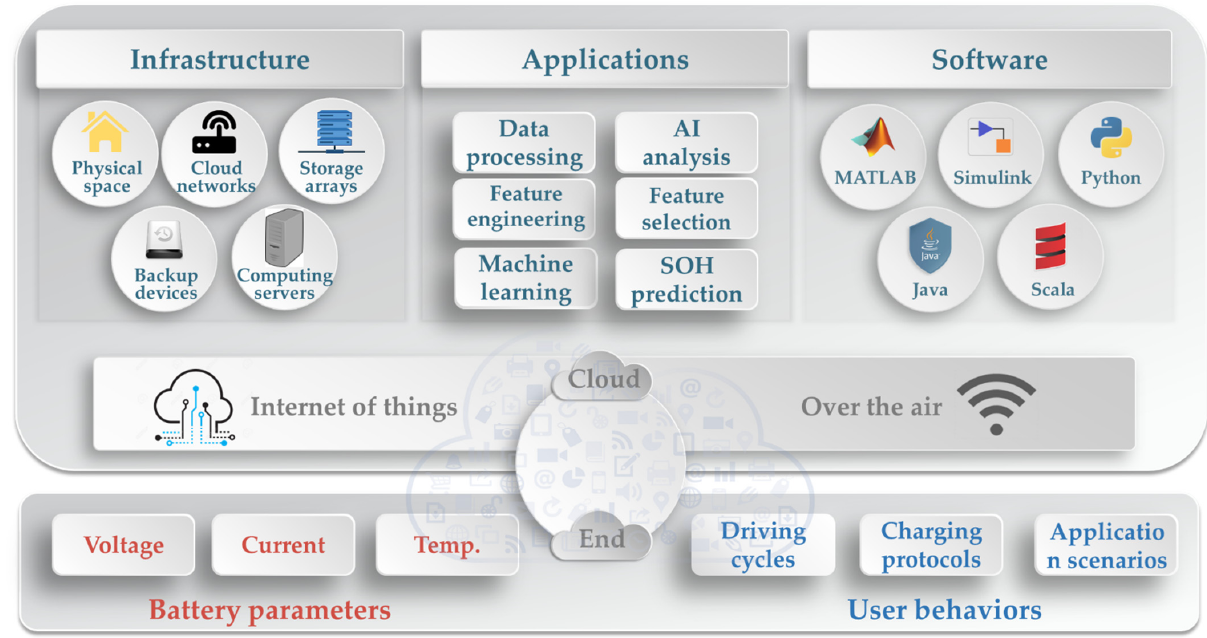
Figure 5. Cloud-based battery SOH estimation and prediction for real-world EV applications. Infra- structure and software constitute essential elements to a cloud platform. The sensor data generated from the Internet of things (IoT)-enabled vehicles can be seamlessly delivered to a cloud. Learning algorithm and physics-based modelling can be conducted on a cloud using both the battery param- eters generated during the daily operation of the battery system and the end-use behaviors during the daily operation of the vehicle. Over the air (OTA) technology provides tools for distributing new software that developed in an offline environment to the onboard actuators. Machine learning pipe- line approach, composed of data processing, feature engineering, feature selection and machine learning modeling, has a crucial role to map from inputs (raw data or engineered features) to target variable (capacity or cycle life, etc.).